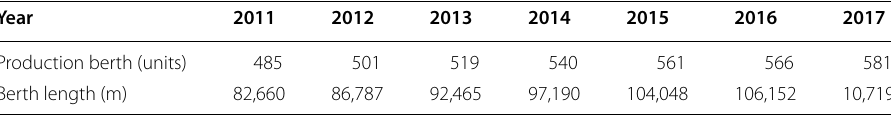
Table 2 Berths of Shandong port. Source : China port